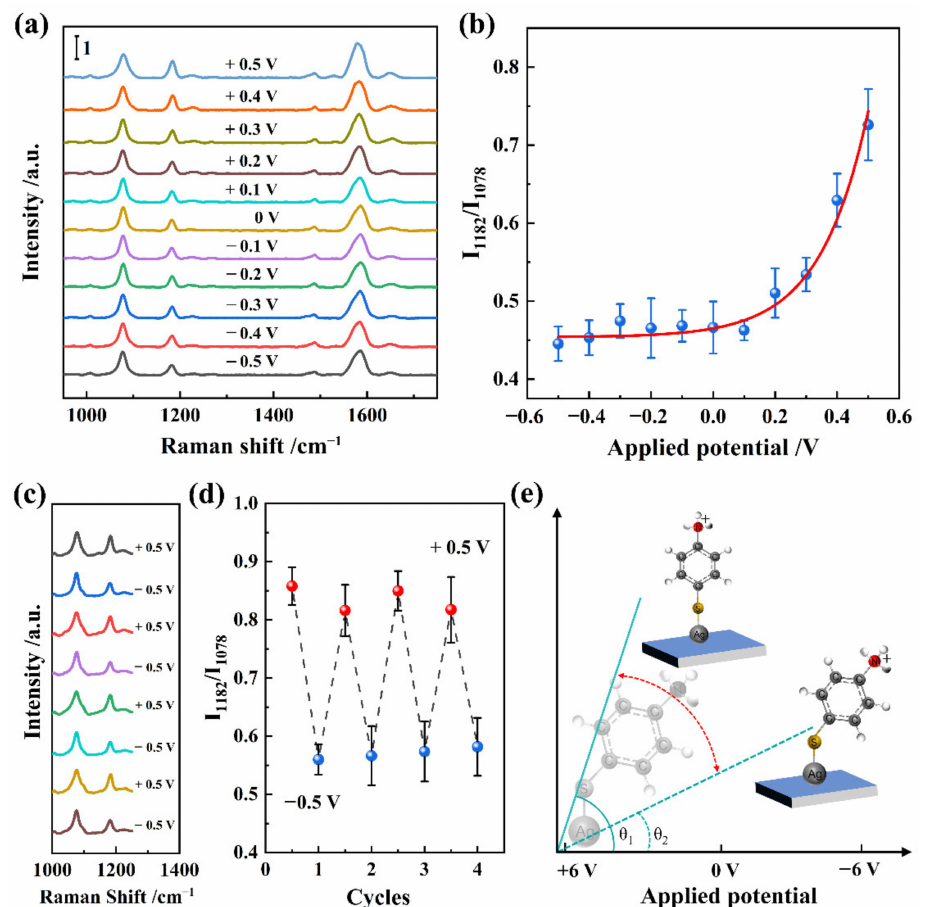
Figure 4. ( a ) In situ SERS profile of PATP adsorbed on Ag-WO 3 − x film under different applied poten- tials. ( b ) Band intensity ratio (I 1182 /I 1081 ) as the function of the applied potential. ( c ) Reproducibility of the potential-dependent SERS profiles under the applied potentials of +0.5 and − 0.5 V. ( d ) Band intensity ratio (I 1182 /I 1081 ) as the function of cycle number. ( e ) Physical model of PATP on the surface of Ag-decorated WO 3 − x film under different applied